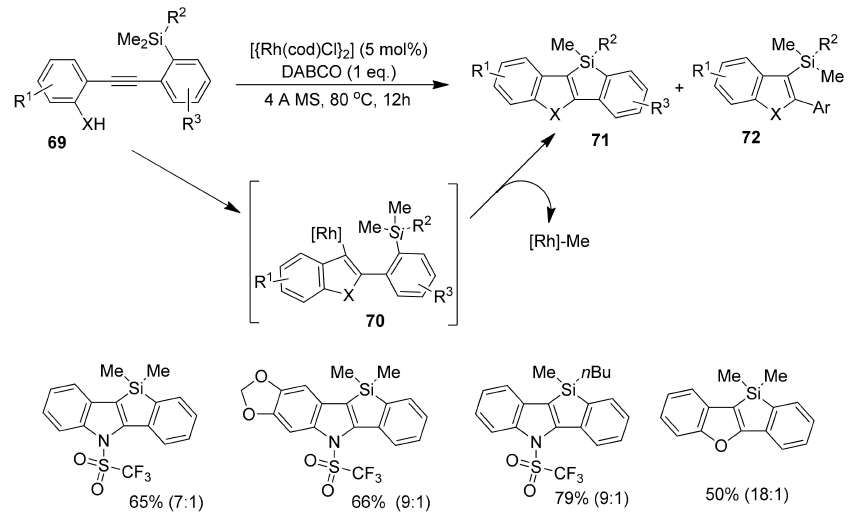
Scheme 13. Rh-catalyzed synthesis of heterocycles-fused